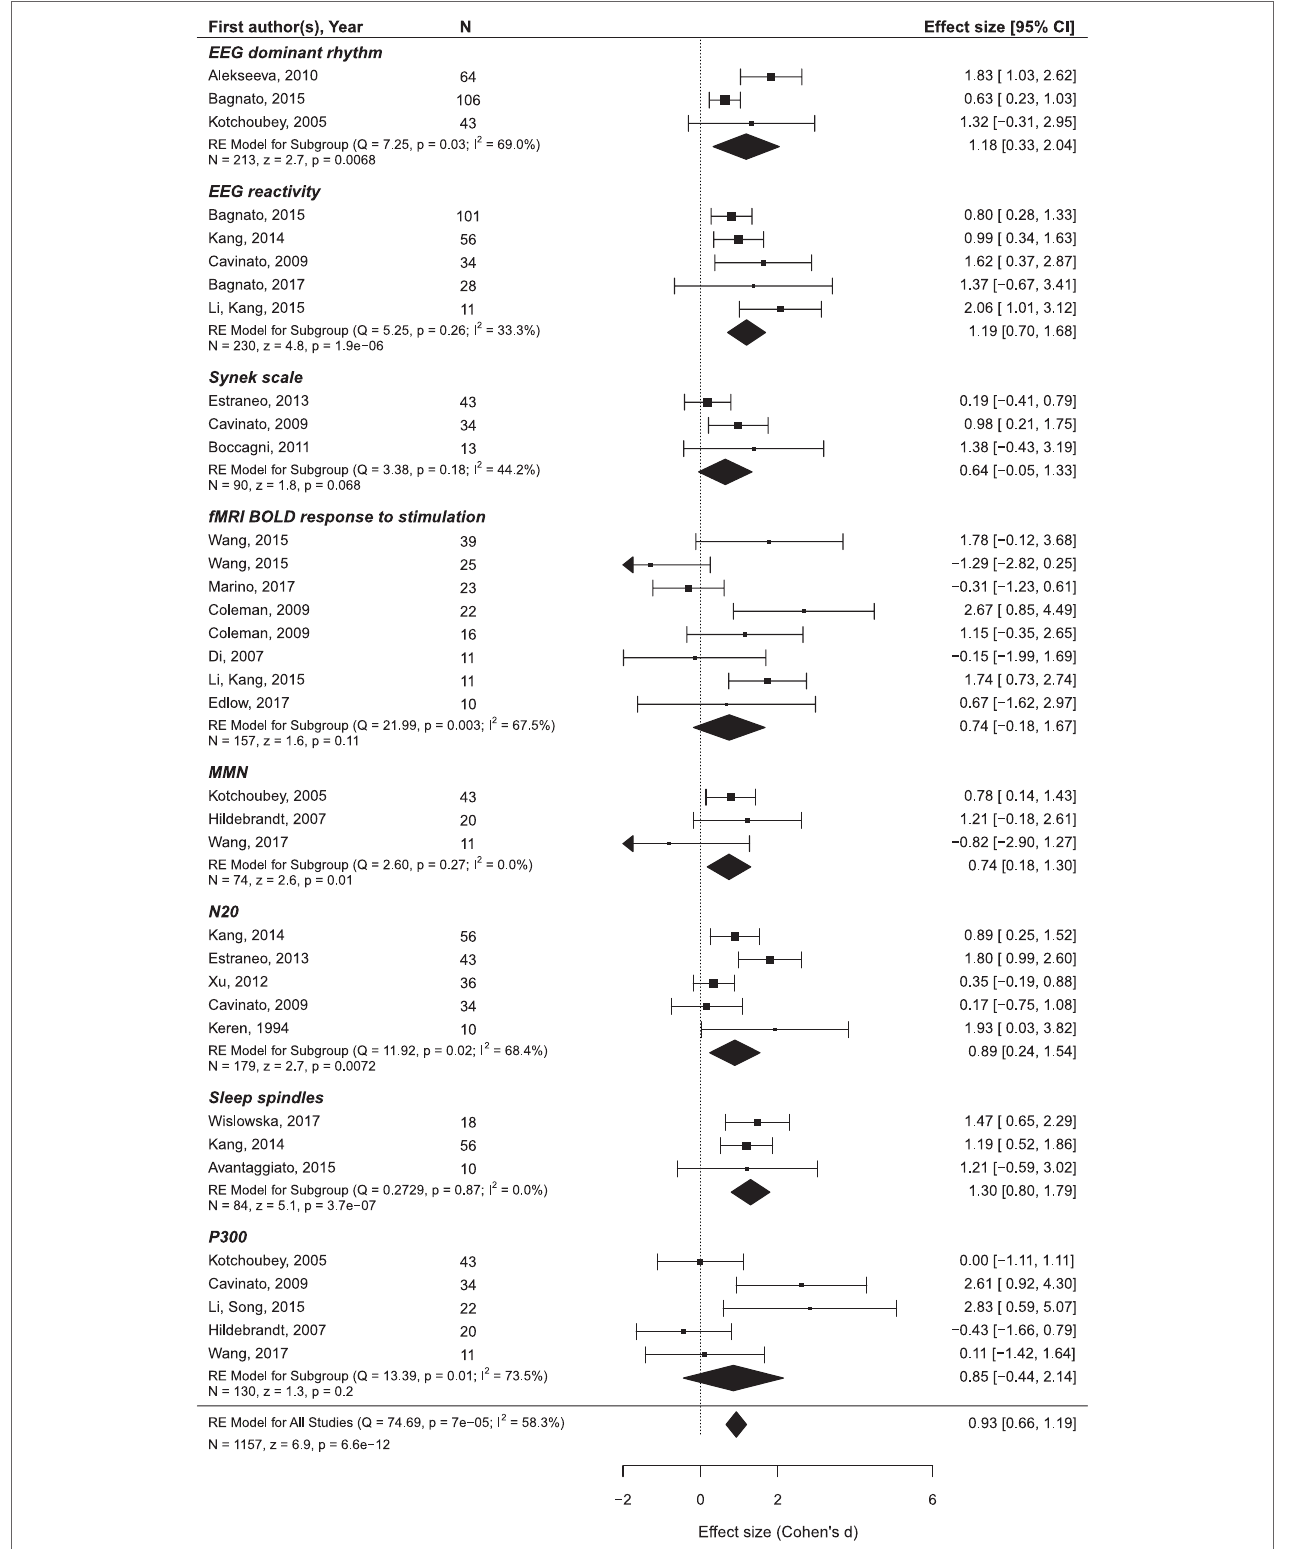
FiguRe 6 | The results of the meta-analysis for prediction of the outcome from neurophysiological variables. The criterion of improvement for UWS patients was the transition to MCS, and for MCS patients, the recovery of consciousness. The rest is the same as in Figure 3